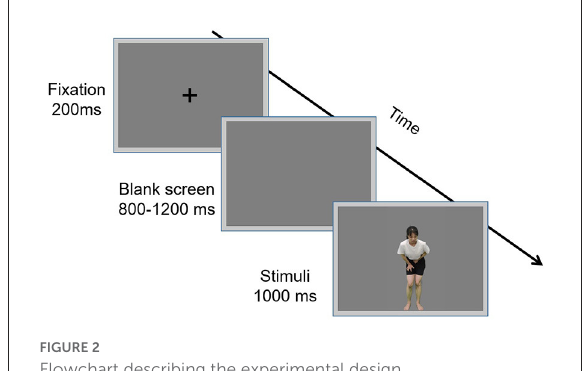
FIGURE2 Flowchart describing the experimental design.